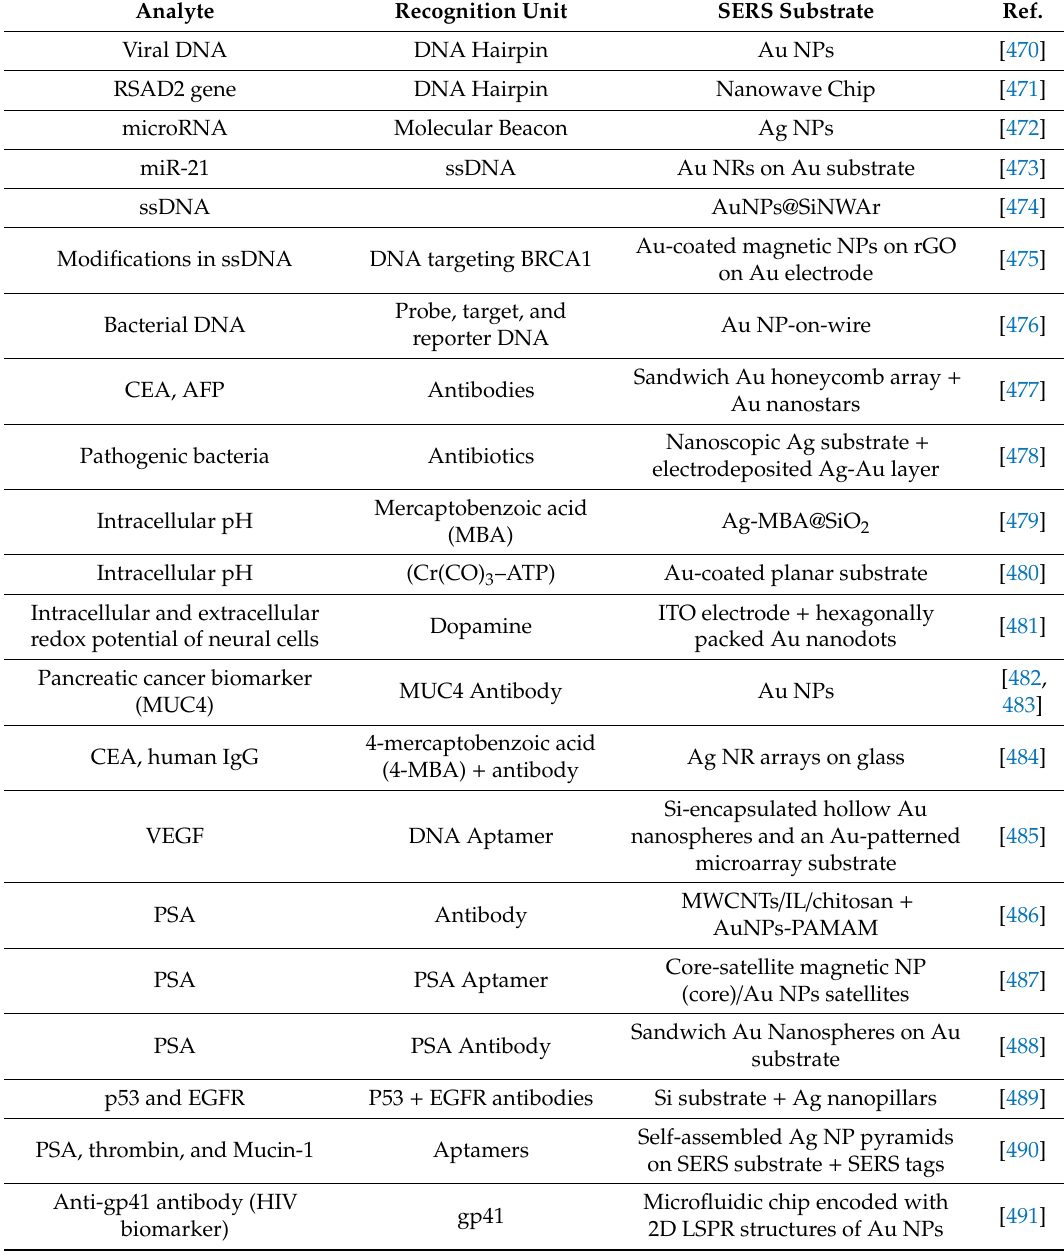
Table 9. Summary of the SERS applications in the biomedical field presented in this review (indirect